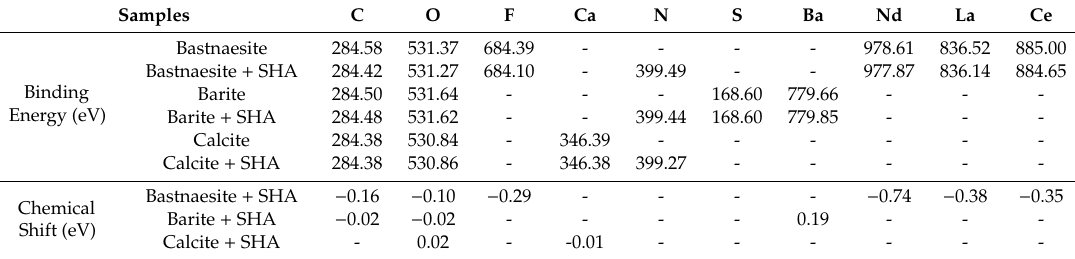
Table 4. Binding energies of elements on the minerals surface, as determined via XPS.